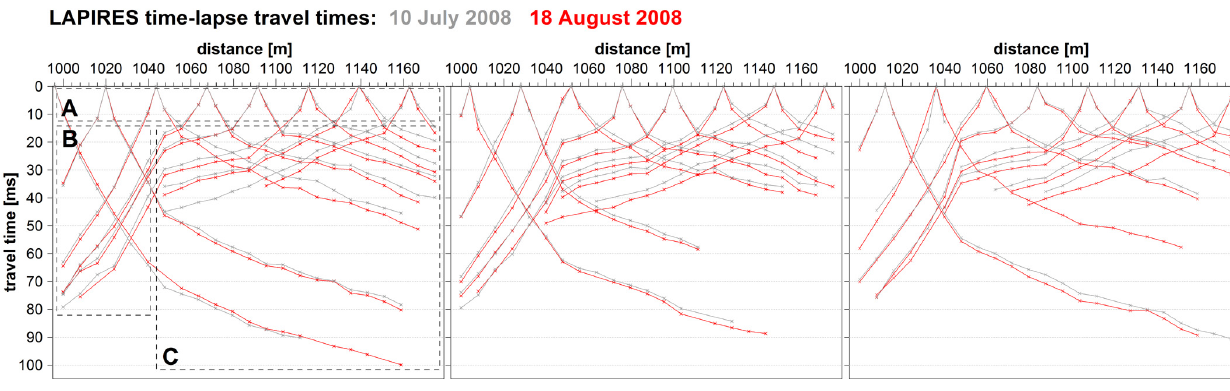
Fig. 4. Comparison of travel times from the Lapires site from 10 July (grey) and 18 August 2008 (red), distributed into three separated plots for clarity. Zones A, B and C are described in the text. Note, that some unpicked traces may change the slope of the travel time